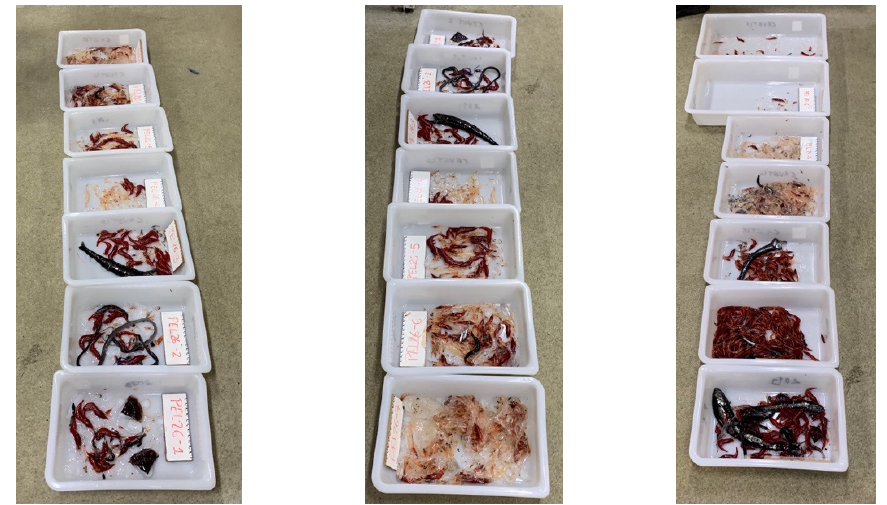
Figure 6. Photographs of the results of three hauls. Observe the difference in the catches for the different strata. Left and right : deeper strata in the front. Middle : deeper strata at the bottom.